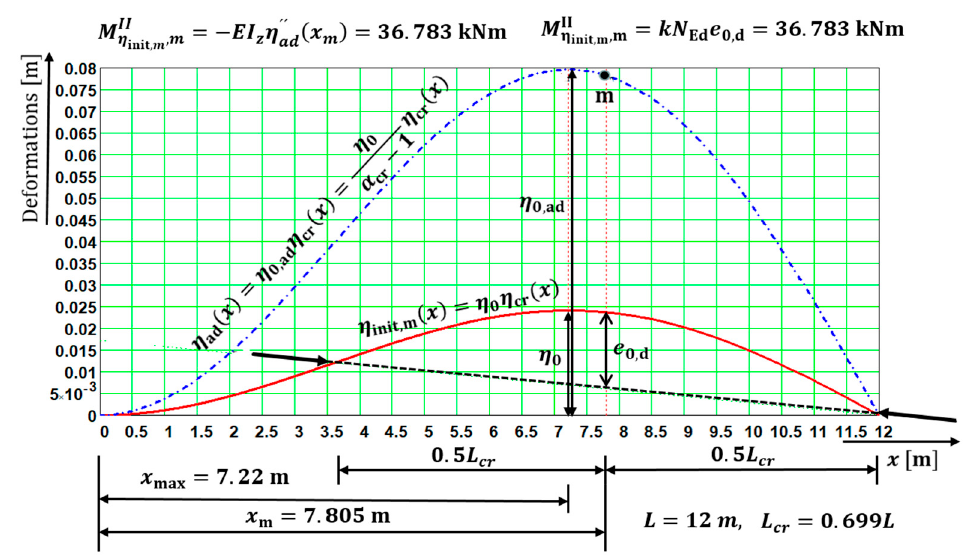
Figure 13. Geometrical interpretations of quantities 𝜂 (cid:2930)(cid:2925)(cid:2930),(cid:2913) 𝑗,⁄ 𝑈 (cid:2898) , 𝑈 (cid:2897) and 𝑈, which are functions of three parameters: 𝛼, 𝜆,and 𝜆 (cid:2868) and quantities 𝛼 (cid:2913)(cid:2928) , 𝑘, 𝑈 (cid:2897),(cid:3032) pend on four parameters: 𝛼, 𝜆,𝜆 (cid:2868) , and safety factor 𝛾 (cid:2897)(cid:2869) . The UGLI imperfection amplitude 𝜂 (cid:2868) for the uniform member with a uniform dis- tribution of axial force had a geometrical interpretation (Figure 14).